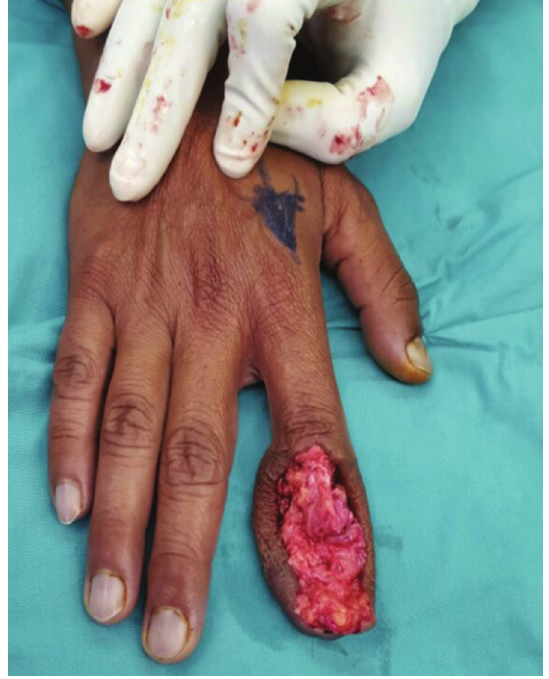
Preoperative images of (a) Dorsal, (b) Volar, (c) Fingertip Fig. 1: and (d) Radiograph of the index finger with bulky soft tissue from previous skin flap.